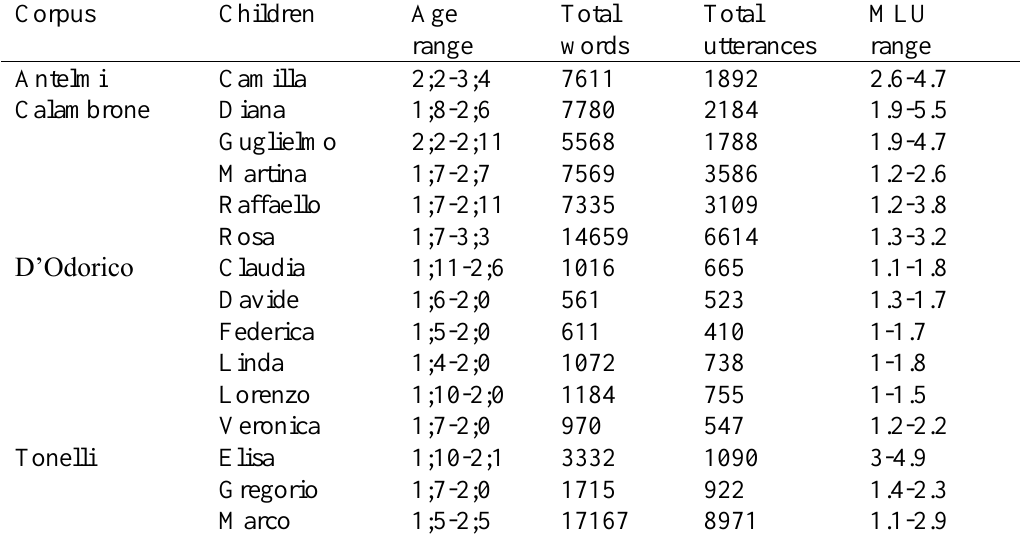
Table 1. Description of the participants’ details Corpus